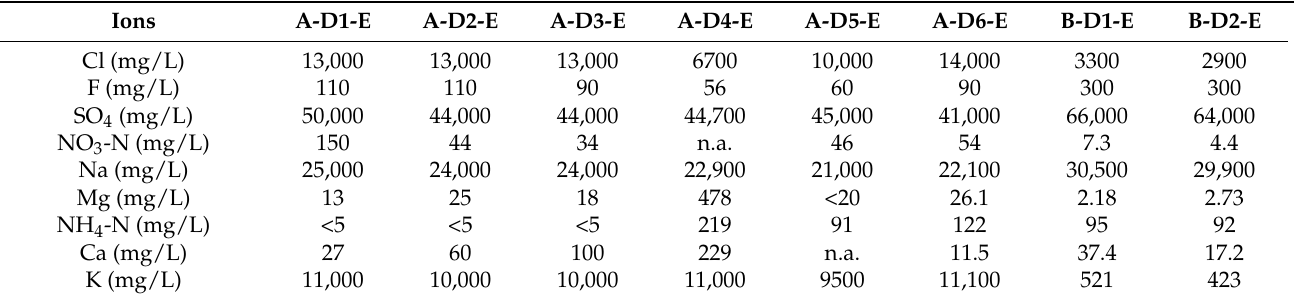
Table 1. Concentration of cations and anions in the eluates of the dusts (dilution